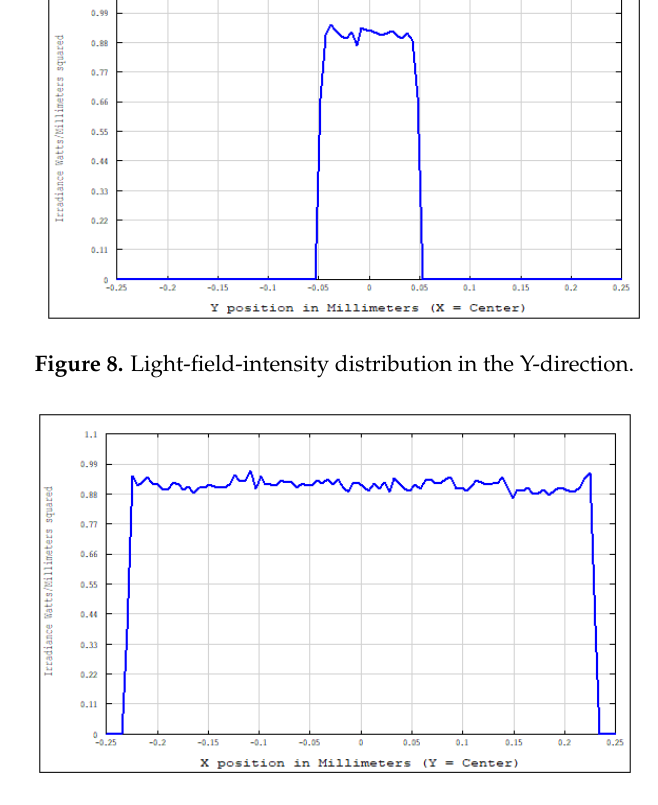
Figure 10. Spot diagram of light-field distribution on the X – Y plane. 3.2.3. Fitting of Aspheric Coefficients of Lenses The nonlinear coefficient of the aspheric surface given in ZEMAX had a particular error; therefore, it was necessary to use the surface sag given in ZEMAX to refit the non- linear coefficient of the surface. The sag data were fitted using Mathematica (MathWorks). When the 4th order coefficient was used, the fitted nonlinear coefficient was 𝑎 4 = 5.11633 × 10 6 . The second aspherical lens was processed in the same way, and its aspheric coefficient was 𝑎 4 = 5.25724 × 10 6 . Table 4 shows the geometric parameters used in the calculations for each of the cy- lindrical lenses.